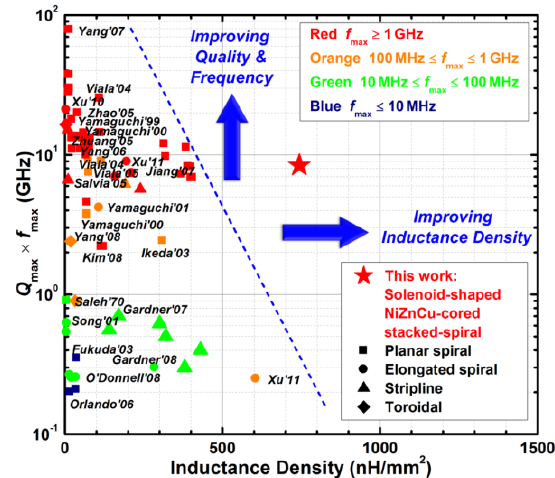
Figure 7. Q max X f max versus L -density chart for the vnM-L inductor and the published state-of-the-art results of lateral magnetic inductors, as well as several high- Q air-cored inductors [22].